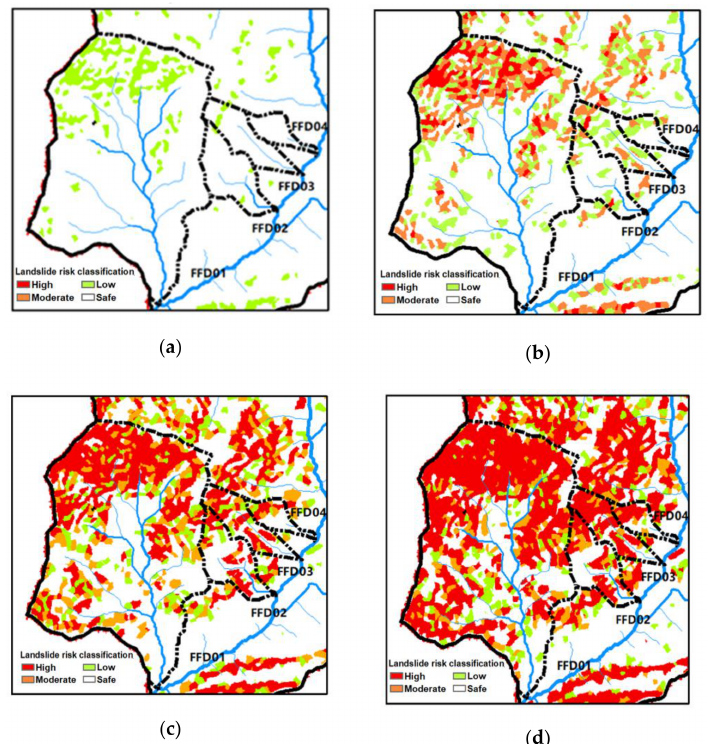
Figure 15. Distribution map of safety factor under different soil moisture content ( a ) 28%; ( b ) 29%; ( c ) 30%; ( d )